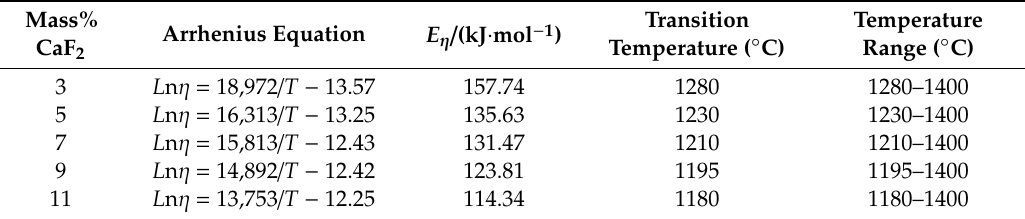
Table 5. The e ff ect of CaF 2 on mold fluxes in activation energy and transition